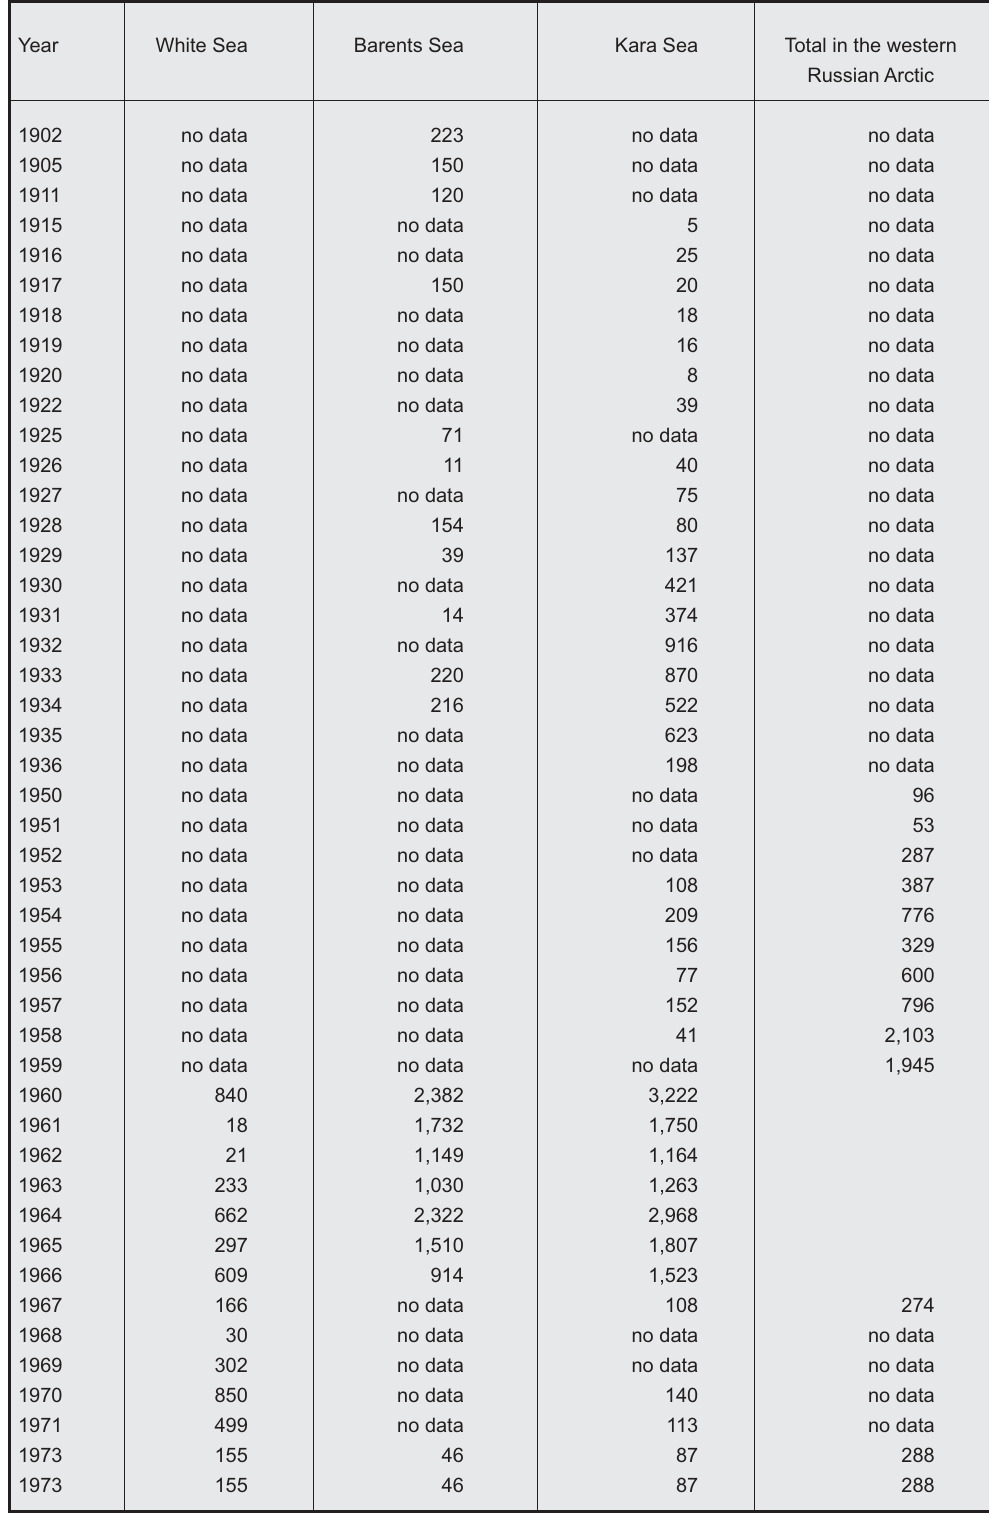
Table 2. Catch statistics 1 of belugas in the Barents, White, Kara and Laptev Seas. Year White Sea Barents Sea Kara Sea Total in the western